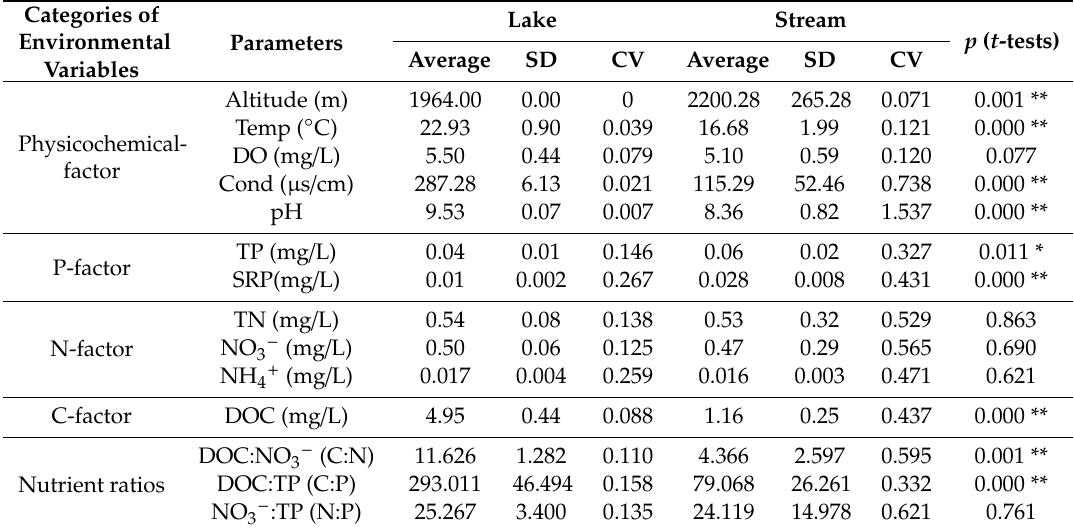
Table 1. Environmental variables in Erhai Lake and